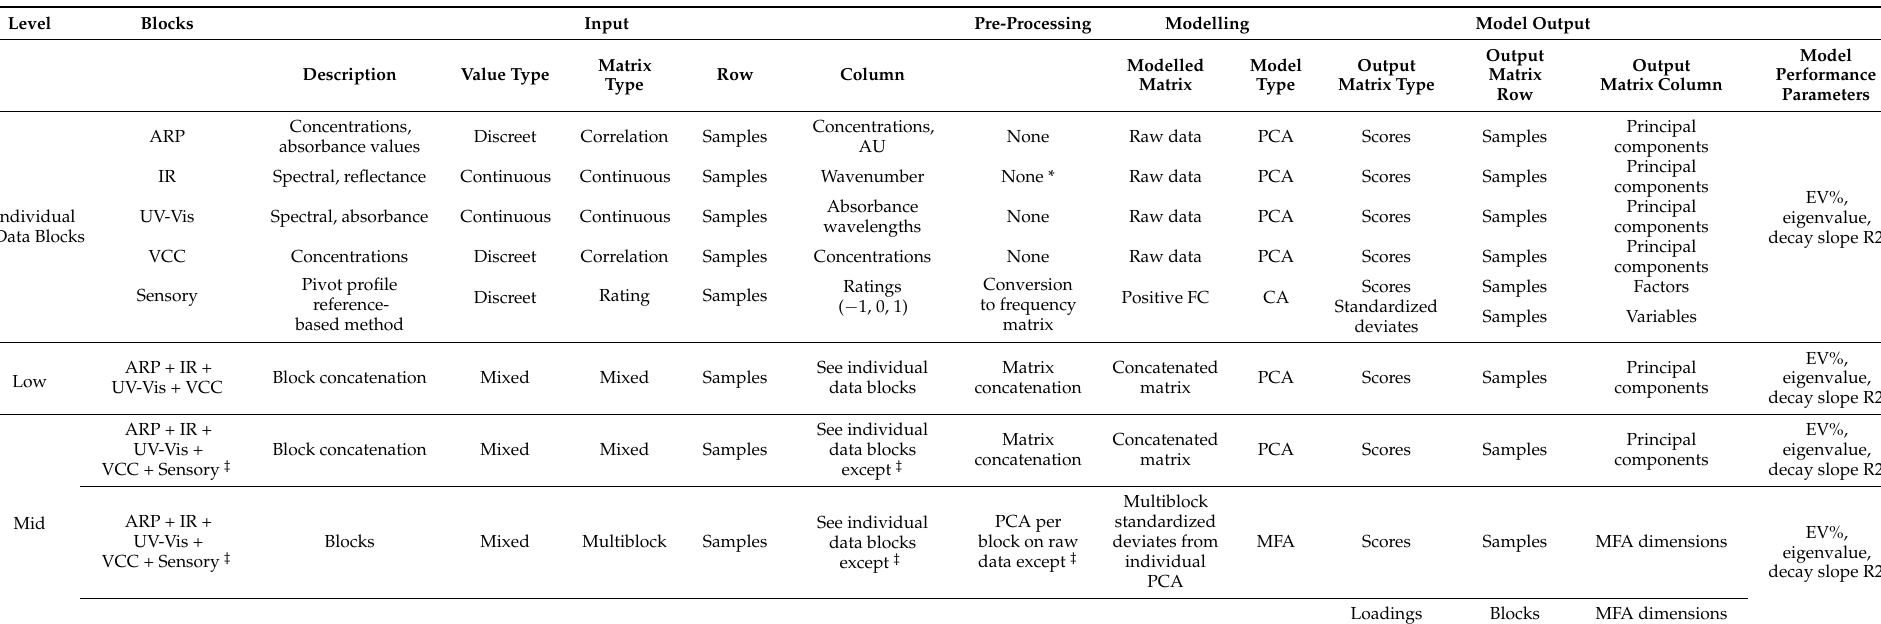
Table 1. Summary of the five blocks, low-level, and mid-level data fusion approaches using multivariate